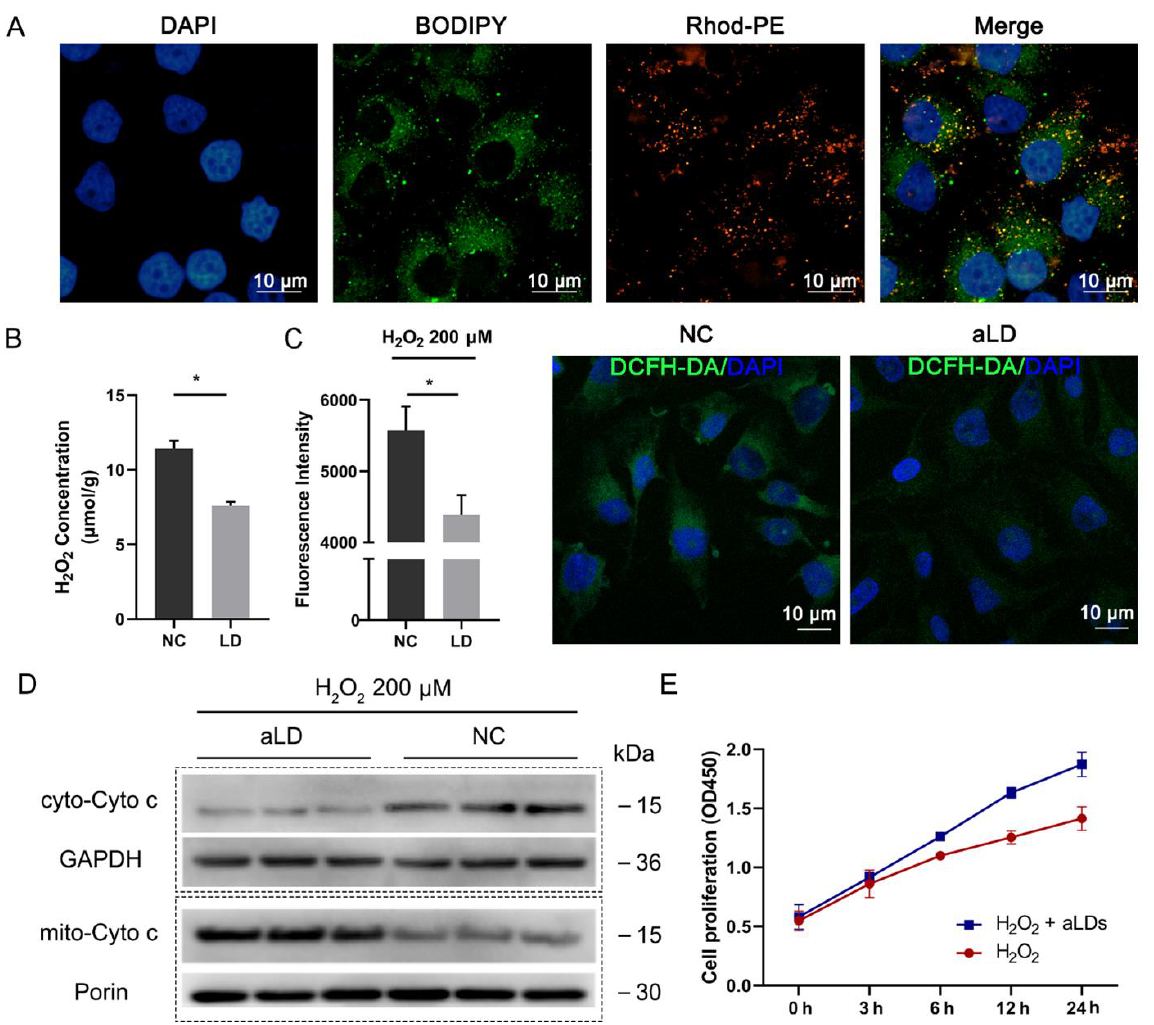
Figure 4. Cellular uptake and resistance to reactive oxygen species (ROS) of Plin5-Coated aLDs. ( A ) Confocal images representing the distribution of fluorescein-labeled LDs in Hela cells. Scale bar: 10 µ m. ( B ) The aLDs were added to 200 µ M H 2 O 2 solution and the H 2 O 2 content in the solution was measured after 30 min incubation. Data are presented as mean ± SD ( n = 3). * p < 0.05. ( C ) Hela cells were incubated with aLDs for 4 h and then treated with 200 µ M H 2 O 2 for 12 h, and DCFH-DA was added to detect the Ros levels of the cells. NC: Hela cells were not incubated with aLDs. Data are presented as mean ± SD ( n = 3). * p < 0.05. Scale bar: 10 µ m. ( D ) Detection of cyto-C release